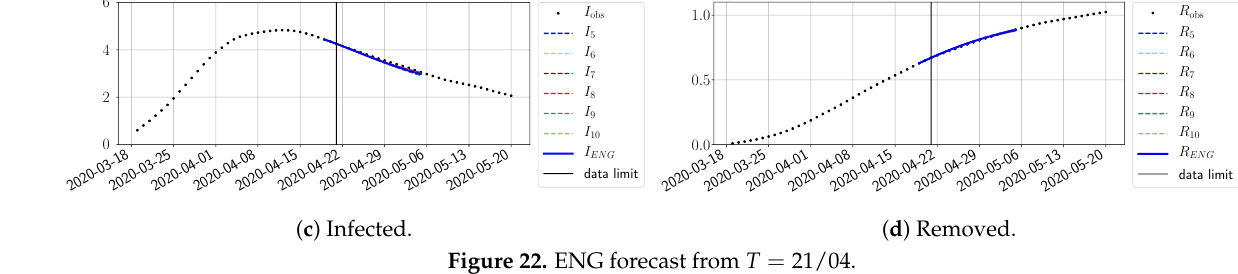
Figure 22. ENG forecast from T = 21/04.